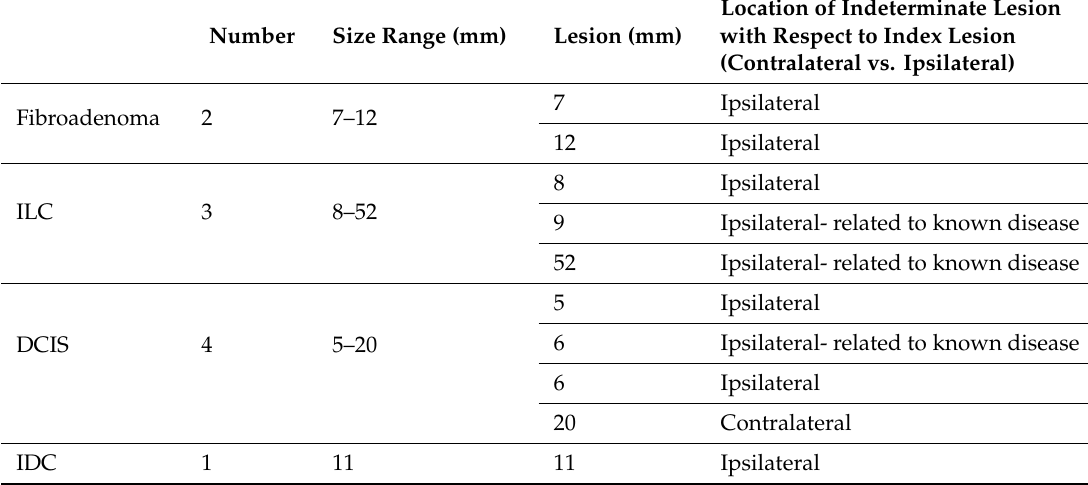
Table 2. Size ranges of the MRI indeterminate lesions.